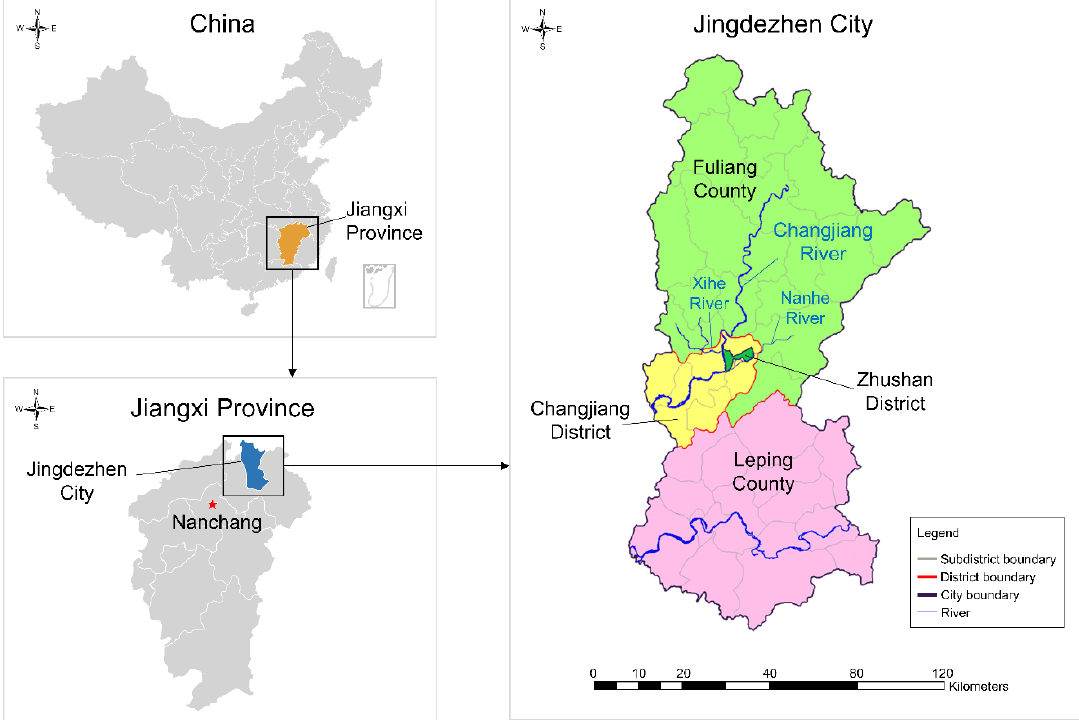
Figure 1. Study area: Jingdezhen City, Jiangxi Province, China.